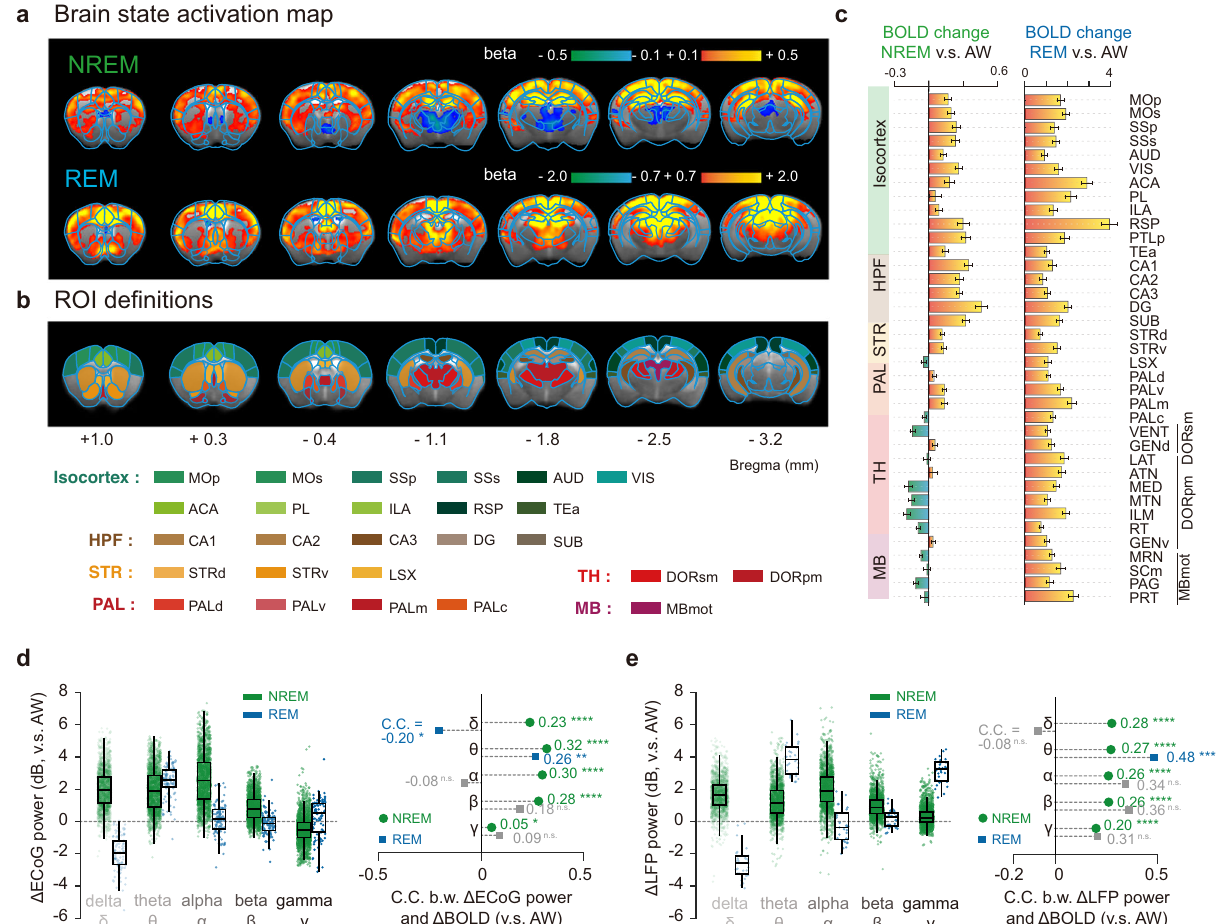
Fig. 3 | Brain-wide BOLD activations of NREM and REM sleep and their elec- trophysiological correlates. a Group BOLD activation maps of NREM and REM compared to AW state (FDR corrected, p <0.05; n =46 sessions from 24 mice). b Region-of-interest (ROI) de fi nitions for extracting the BOLD changes in ( c ). Abbreviations of ROIs were listed in Supplementary Data 1. c Mean (+/ − SEM) relative BOLD changes of NREM and REM compared to AW state (sample size: n =46 sessions from 24 mice). d , e Electrophysiological correlates of sleep dependent BOLD changes. Left panel, relative ECoG ( d ) or LFP ( e ) band-limited powerinNREMand REMcompared to AW state. Right panel, Pearson ’ s correlation coef fi cients (C.C.) between relative ECoG ( d ) or LFP ( e ) band-limited power and